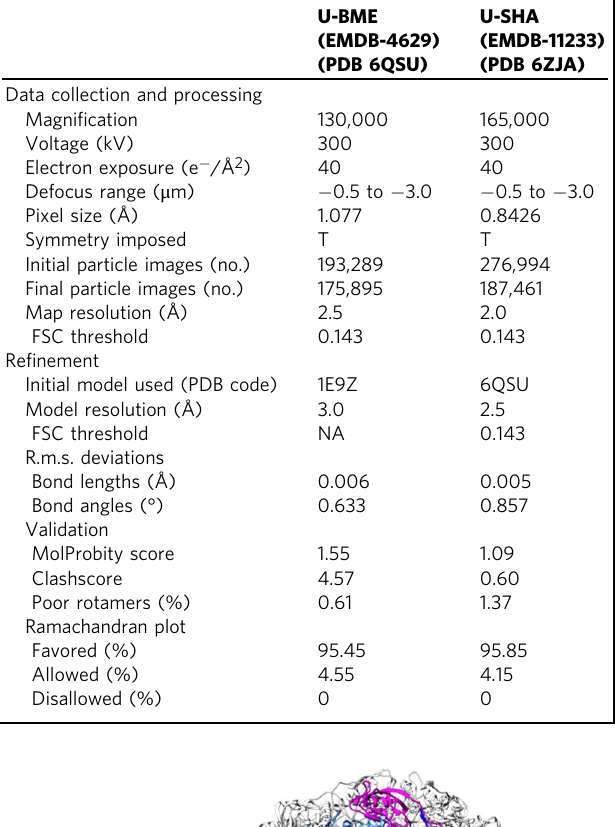
Table 1 Cryo-EM data collection, re fi nement, and validation statistics.